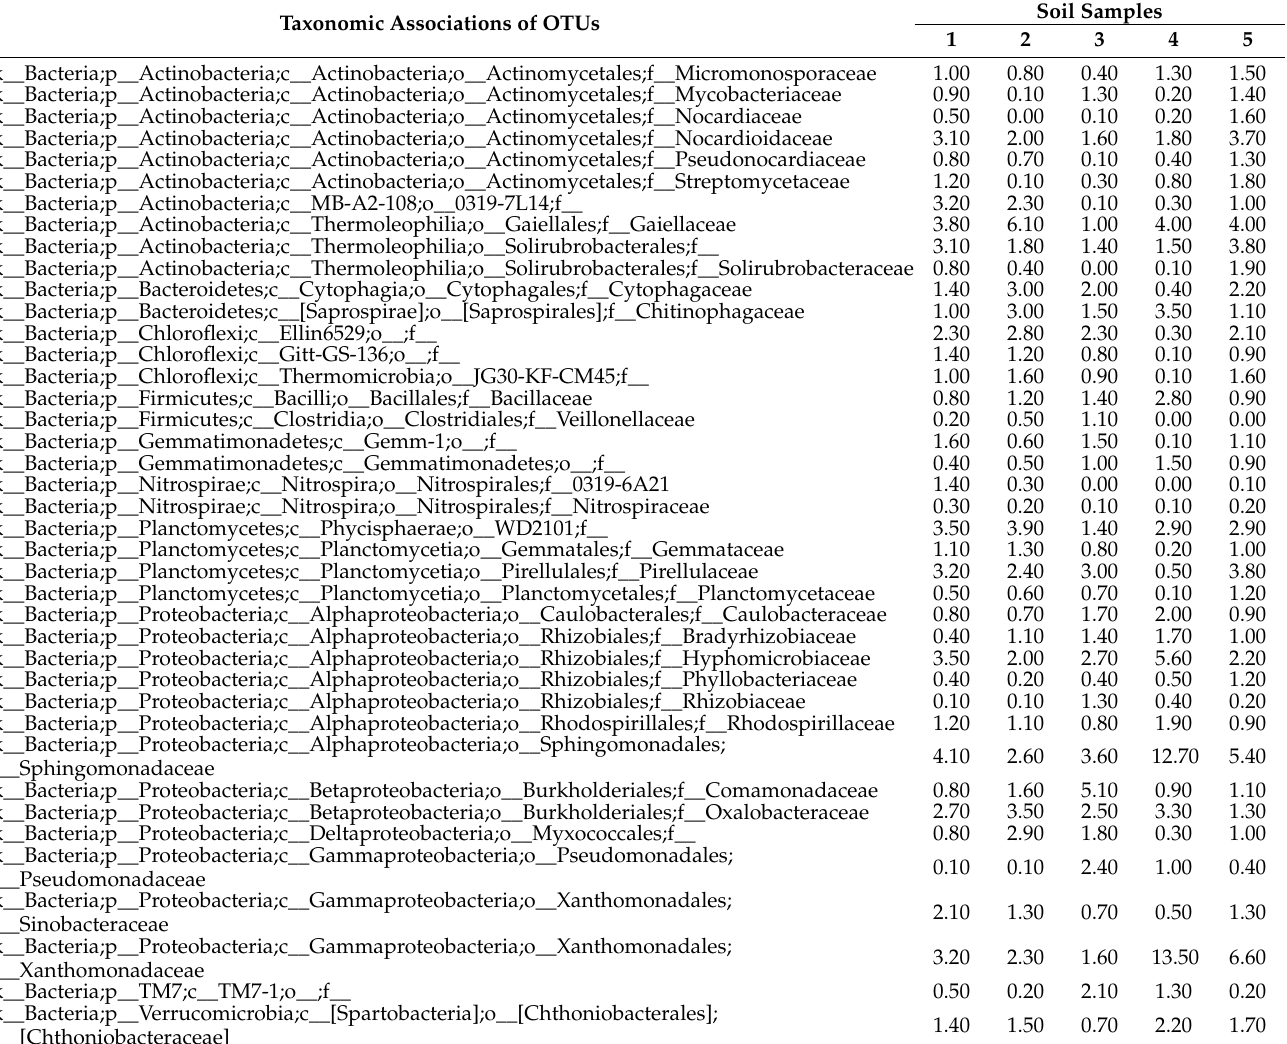
Table A1. Cont. Taxonomic Associations of